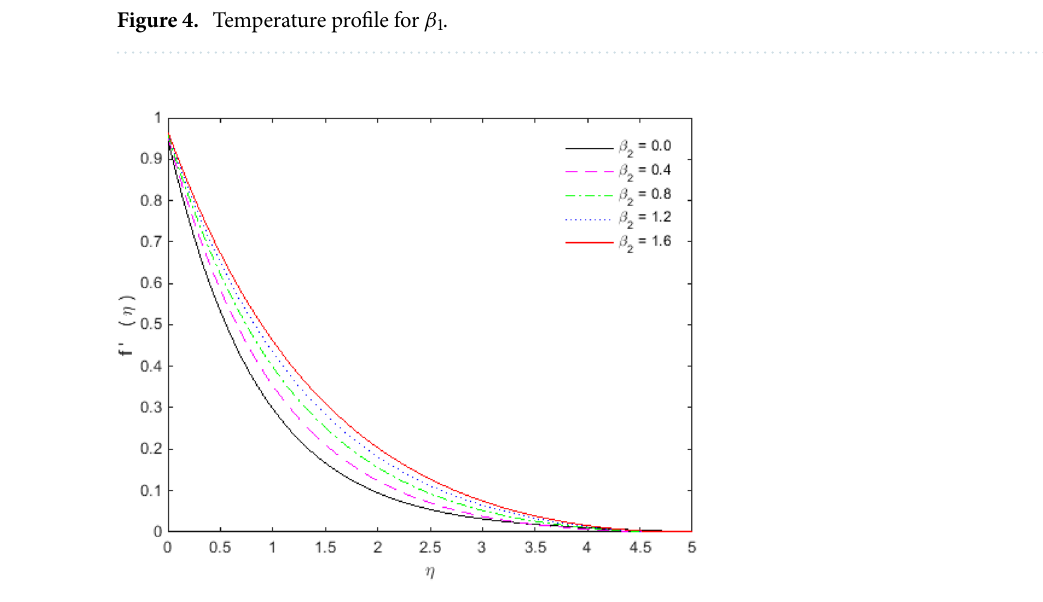
Figure 5. Streamwise velocity profile for β 2 .